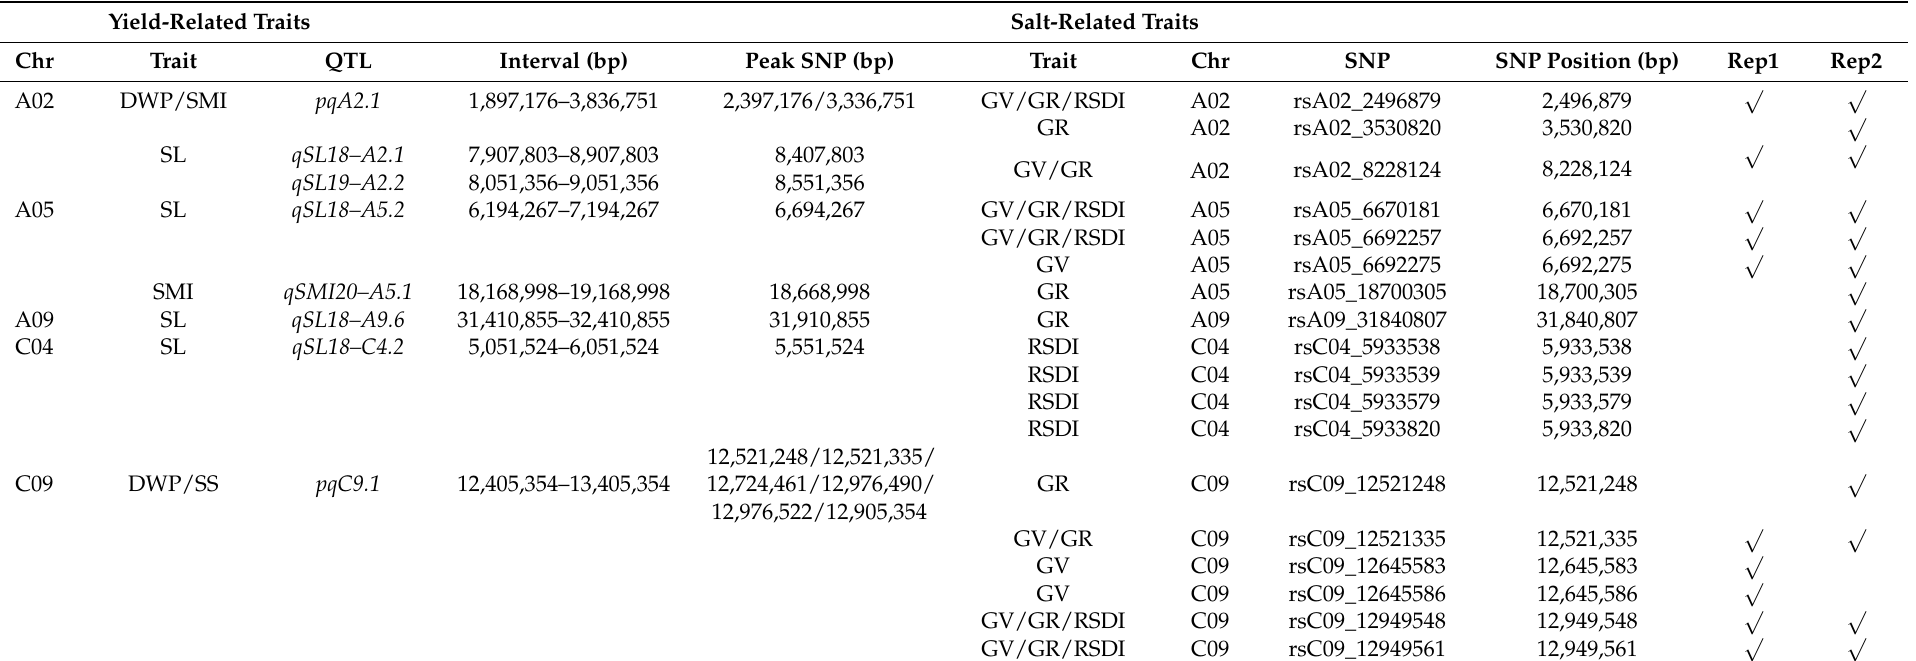
Table 2. Co-localized SNPs’ association between the salt tolerance and the yield-related